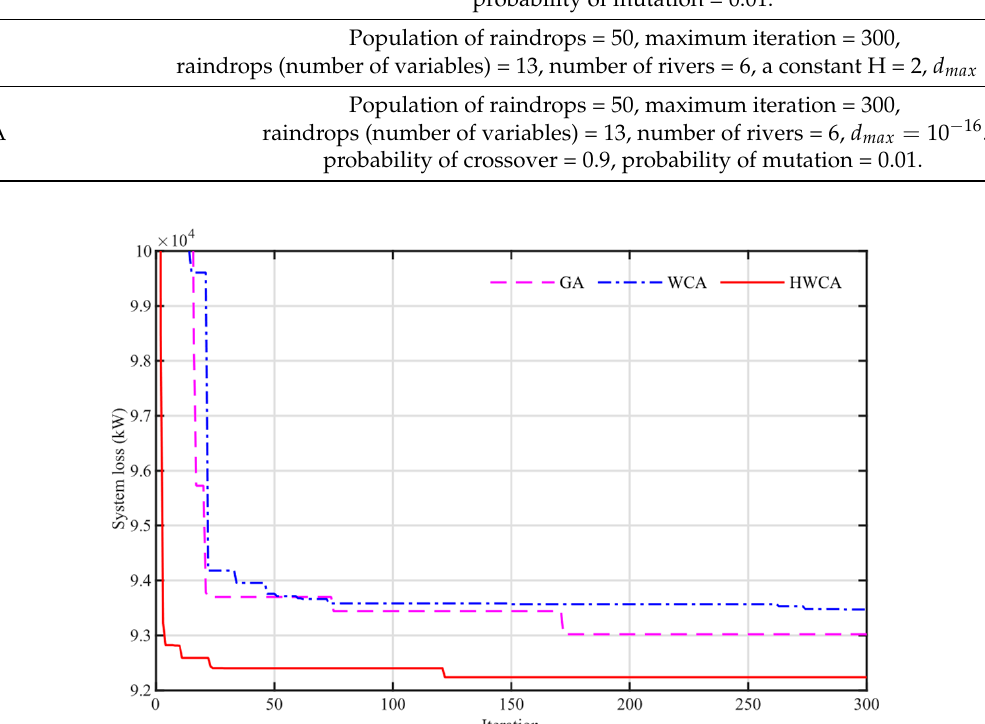
Figure 11. Convergence curve of the IEEE 33-node system using compared algorithms for case 6. Table 4. Compared numerical results of HWCA for case 6 with WCA and GA for the 69-node sys- tem.